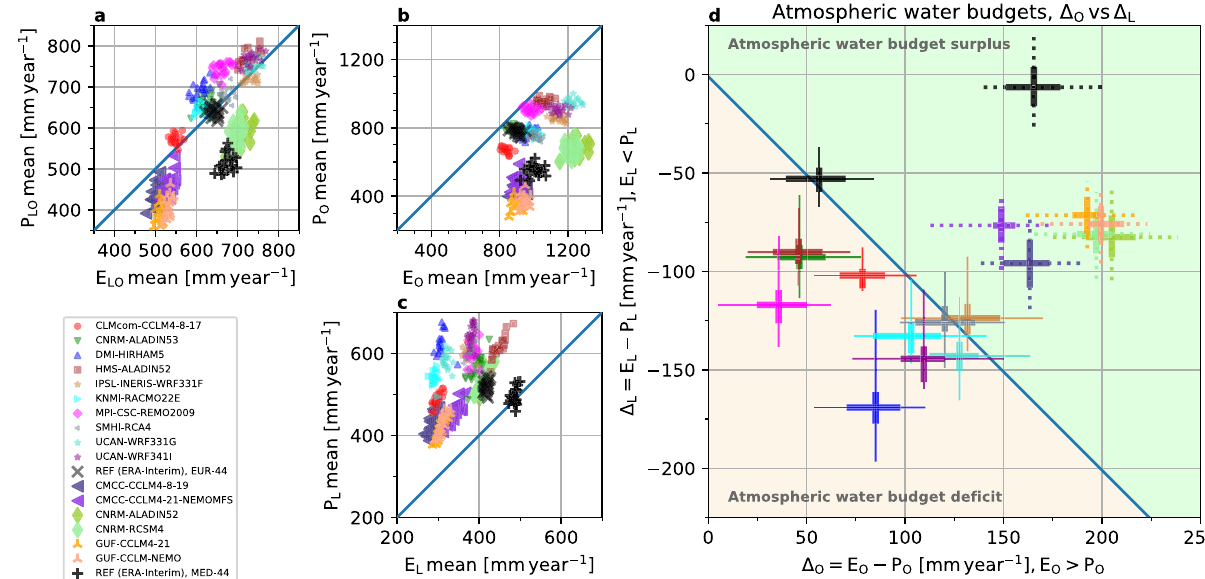
Figure 5. Relationship of E versus P for ( a ) all grid points, ( b ) ocean grid points, ( c ) land grid points; spatial means of annual sums for 20 years from 1989 to 2008 for the EURO-CORDEX RCMs (upper 10 coloured symbols) and accompanying REF data (black cross) and the Med-CORDEX RCMs and AORCMs (lower 6 coloured symbols) and accompanying REF data (black plus sign); note the different data ranges among the individual plots. ( d ) Atmospheric water budget over the ocean (x-axis) versus over land (y-axis); EURO- CORDEX models: solid lines, Med-CORDEX models: stippled lines; due to differences in the areal fraction of land and ocean grid elements, the spatial means of the annual sums per RCM and REF are weighted with the respective number ocean and land grid points; whiskers as thin horizontal and vertical lines along Δ O and Δ L denote minimum and maximum, their intersection is the Δ O and Δ L arithmetic mean; the boxes as thick horizontal and vertical lines show the interquartile range. The same symbols are used for the same RCM family; each simulation uses a different model configuration. For legibility the individual annual realisations per model from sub-figure ( a , b , c ) are not shown in sub-figure ( d ); the colour-coding is retained for each